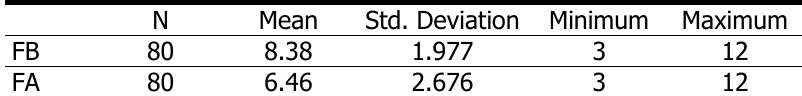
Table 10. Fantasy Motivation Descriptive Statistics